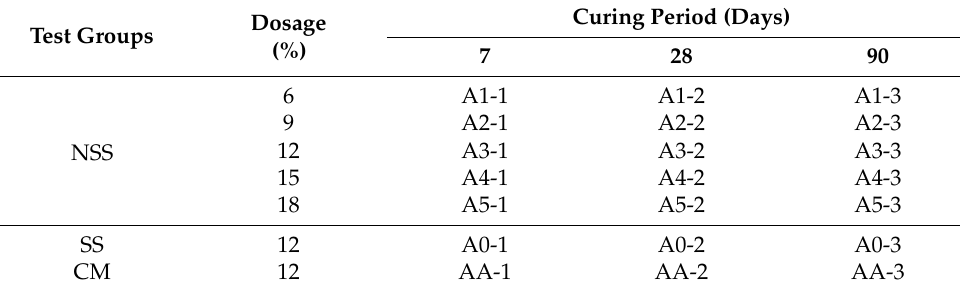
Table 2. Mix proportions of each experimental group.